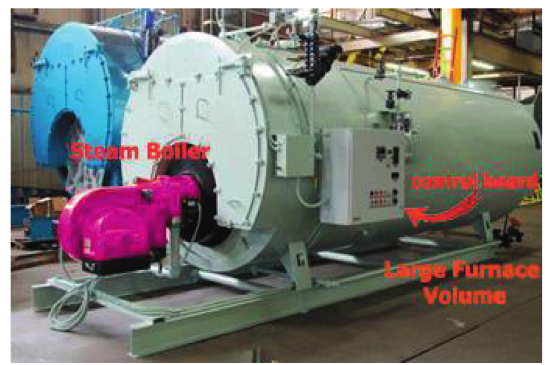
Figure 1: A power plant boiler.